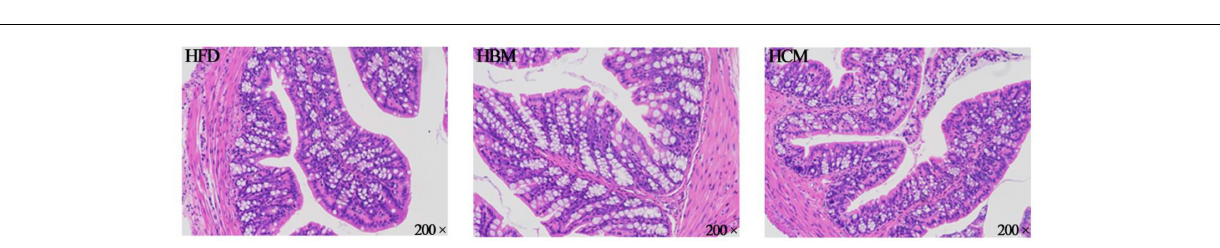
FIGURE 4 | Effects of buffalo and cow milk on morphology of colon tissues in mice fed by high fat diet. H & E staining of the colon morphology from representative mice of each group (200 ×